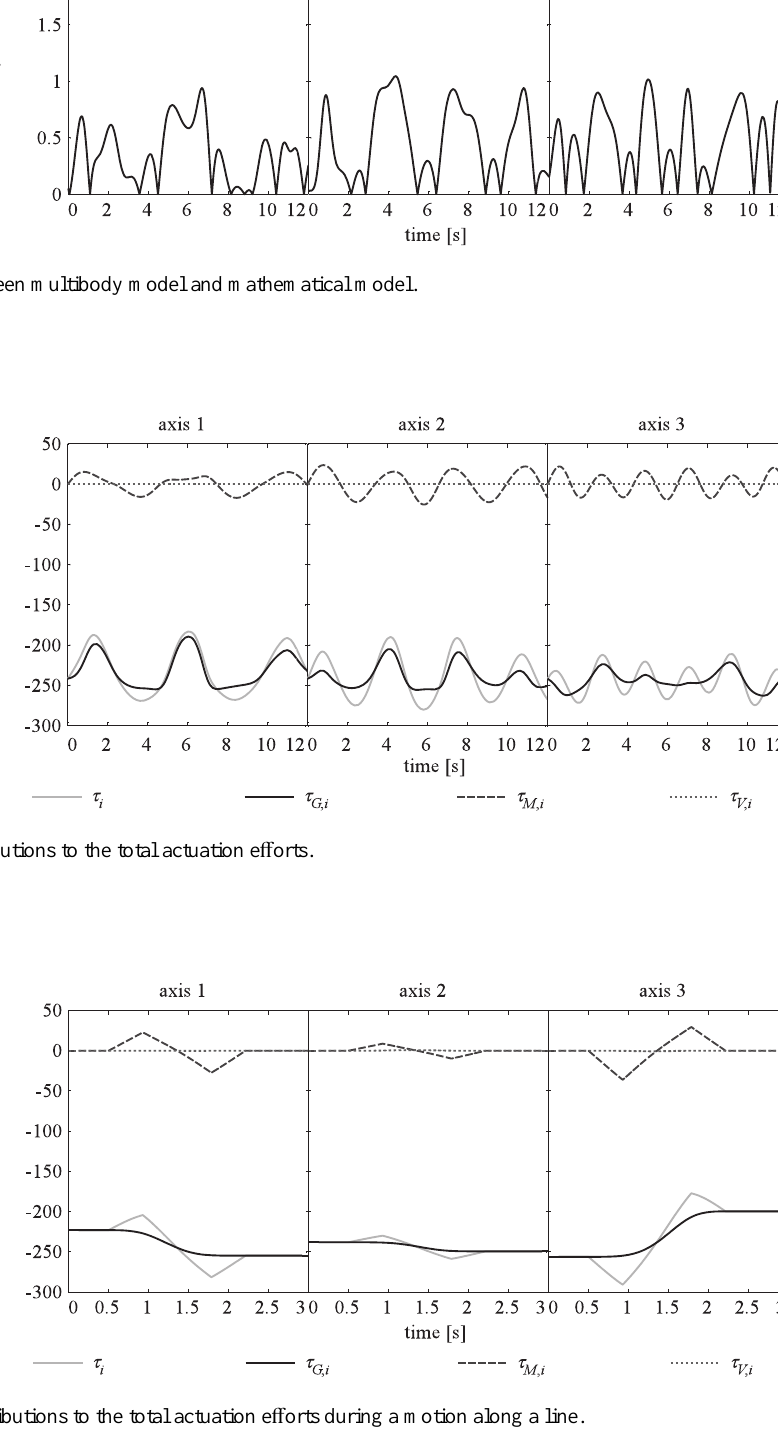
Mech. Sci., 4, 185–197,